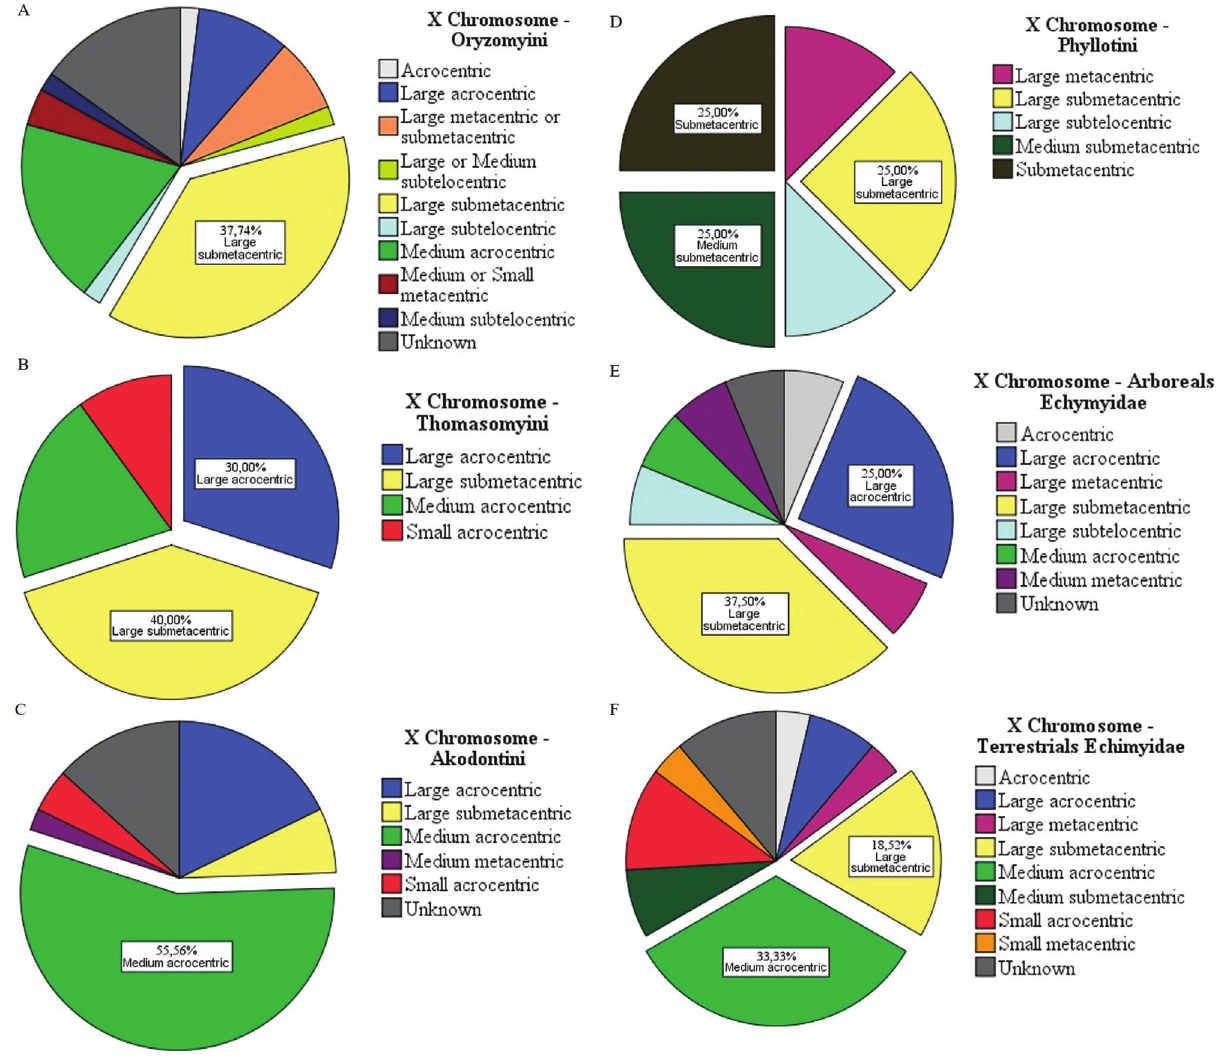
Figure 2 - The most usual X chromosomal forms observed for the Sigmodontinae subfamily: (A) Oryzomyini tribe, (B) Thomasomyini tribe, (C) Akodontini tribe, and (D) Phyllotini tribe. The families: Echimyidae (divided by their habits of life) (E) arboreal Echimyidae and (F) terrestrial